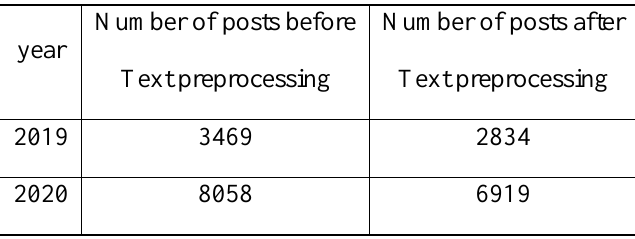
Table 2 indicated reducing the number of Instagram posts from 3649 to 2834 in 2019 and